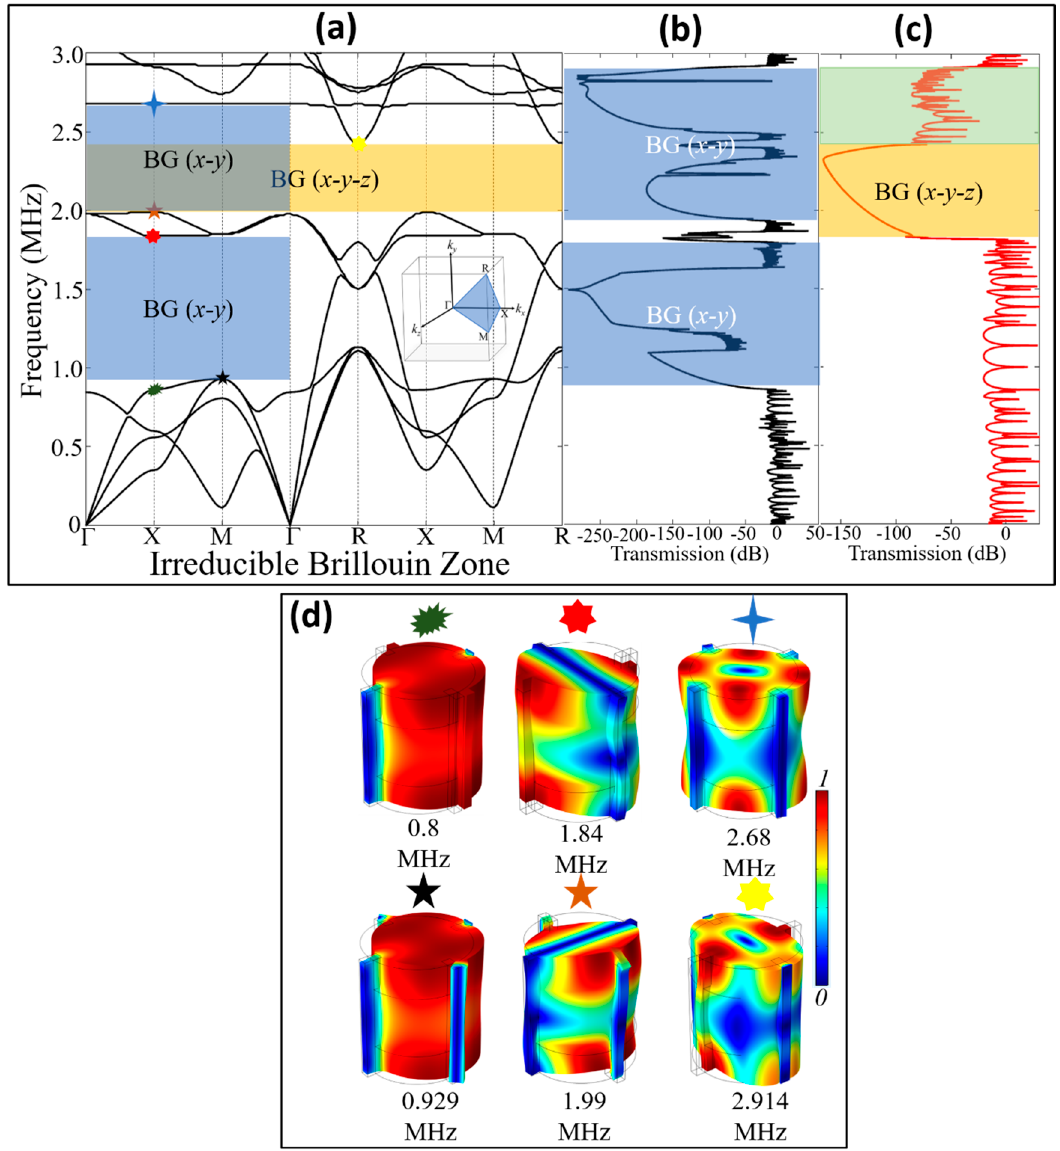
Figure 3. ( a ) The 3D band structure of PnC unit cell structure, with irreducible Brillouin zone (IBZ) shown at the inset. ( b , c ) transmission curve for harmonic excitation applied in the x-y and the x-y-z directions. The BGs are highlighted. ( d ) The vibration modes involved in the opening and closing of BGs.